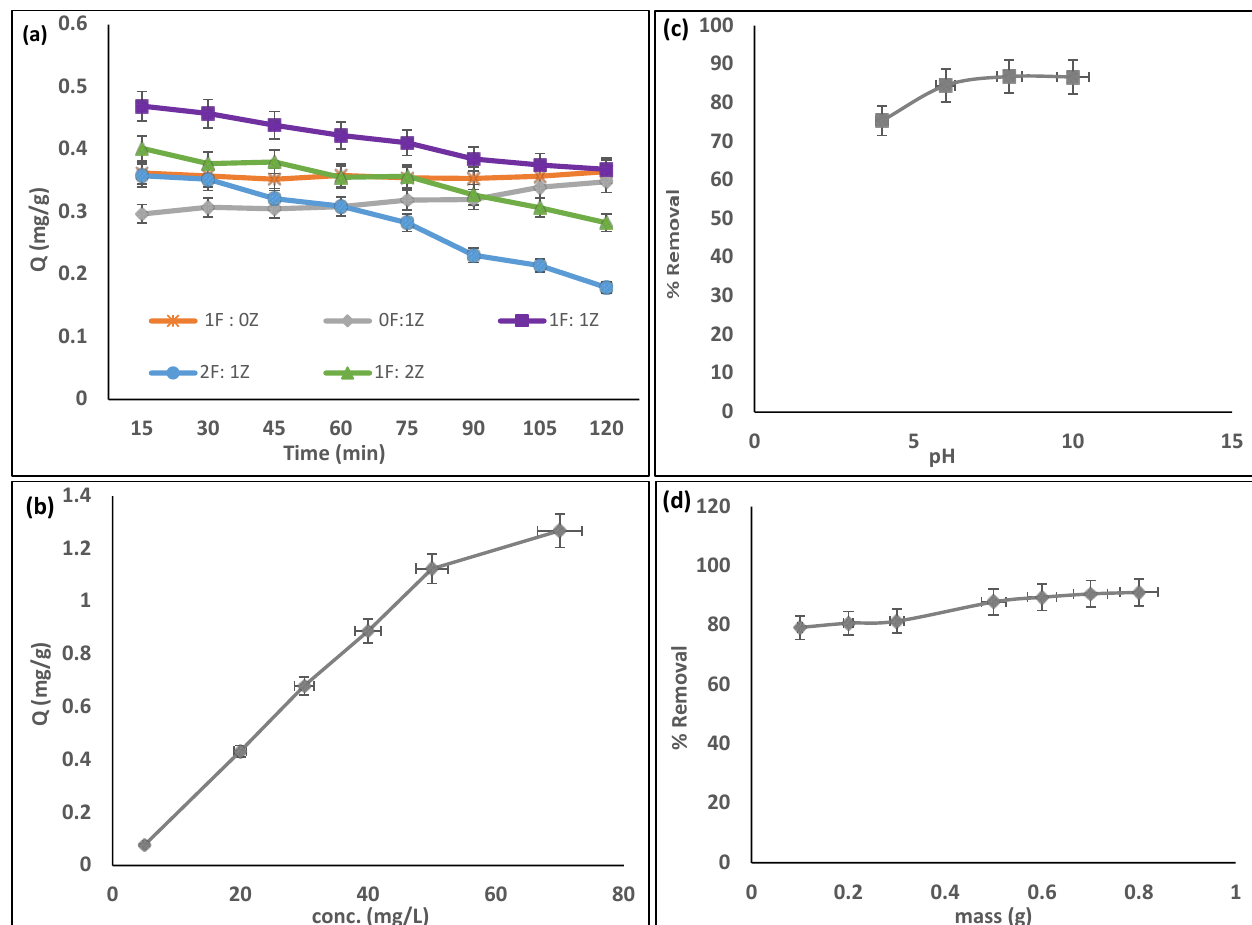
Figure 4. The effects of different factors on the MB dye removal capacity of Zeo-FPT: ( a ) contact time at different ratios of Zeo-FPT; ( b ) solution concentration of Zeo-FPT (1F:1Z); ( c ) the removal percentage at different pH values; and ( d ) the mass of Zeo-FPT (1F:1Z).